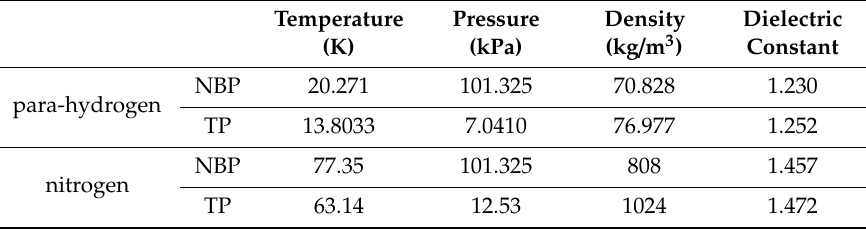
Table 1. Thermophysical properties of para-hydrogen [17] and nitrogen [18] at normal boiling point (NBP) and triple point (TP).